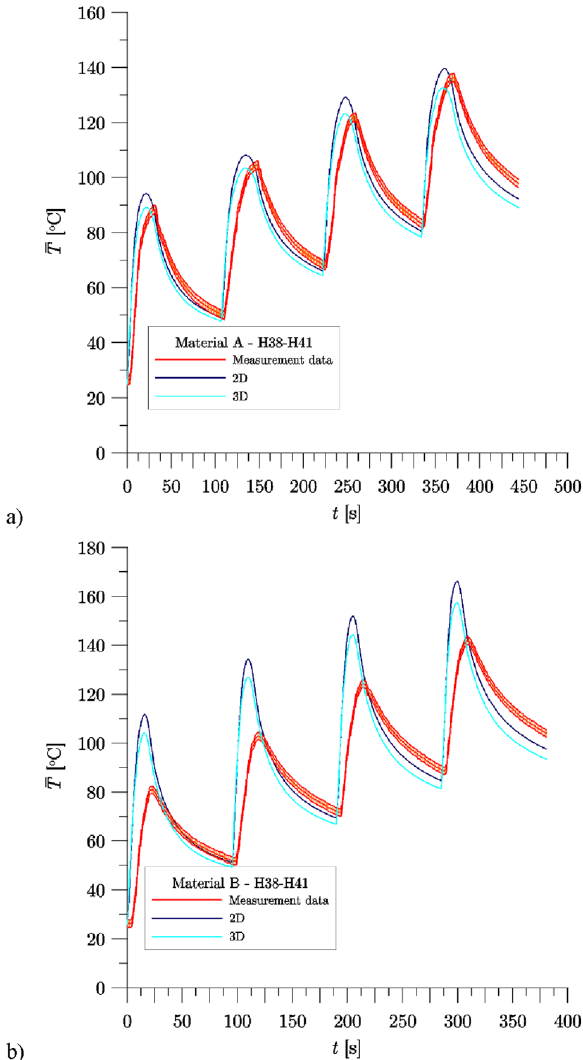
Figure 9. Change of average temperature under the wheel tread during braking H38–H41—comparison of experimental data and numerical calculation results for each temperature measurement points: ( a ) Material A; ( b ) Material B. Experimental data include the maximum uncertainty of the average temperature measurement